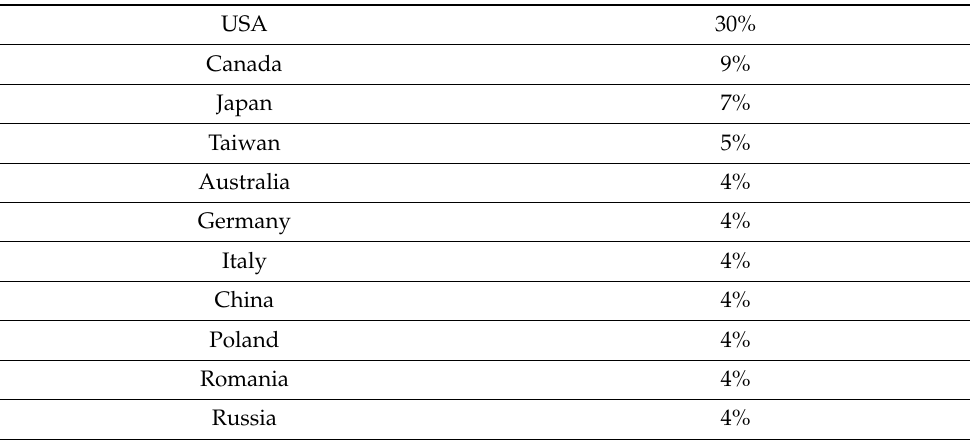
Table 1. Geographical origin of robot tax research in Web of Science’ database.